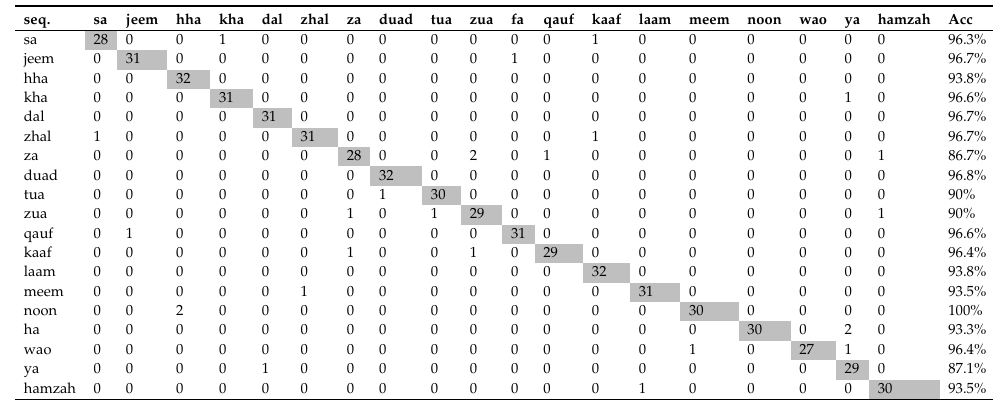
Table 6. DCNN with data augmentation.